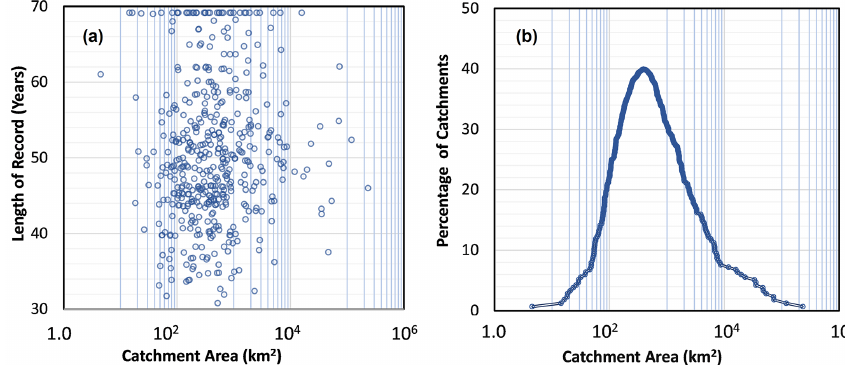
Figure 2. Catchment area plotted against (a) the length of record and (b) the percentage of